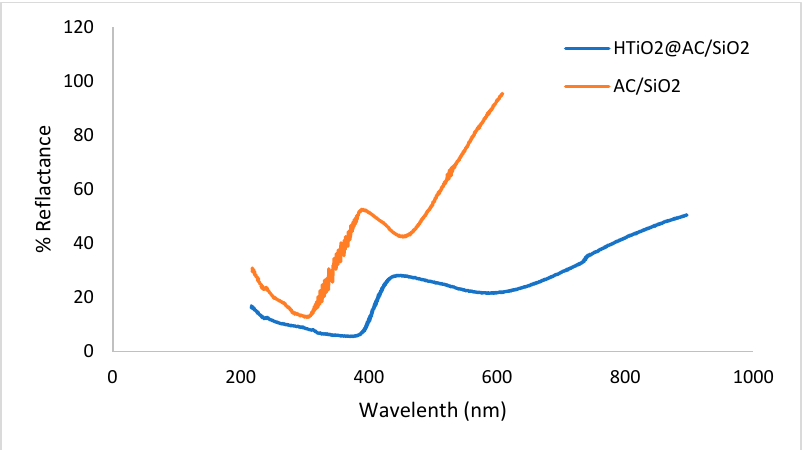
Figure 5. The reflectance spectra of the prepared AC/SiO 2 and HTiO 2 @AC/SiO 2 composites .